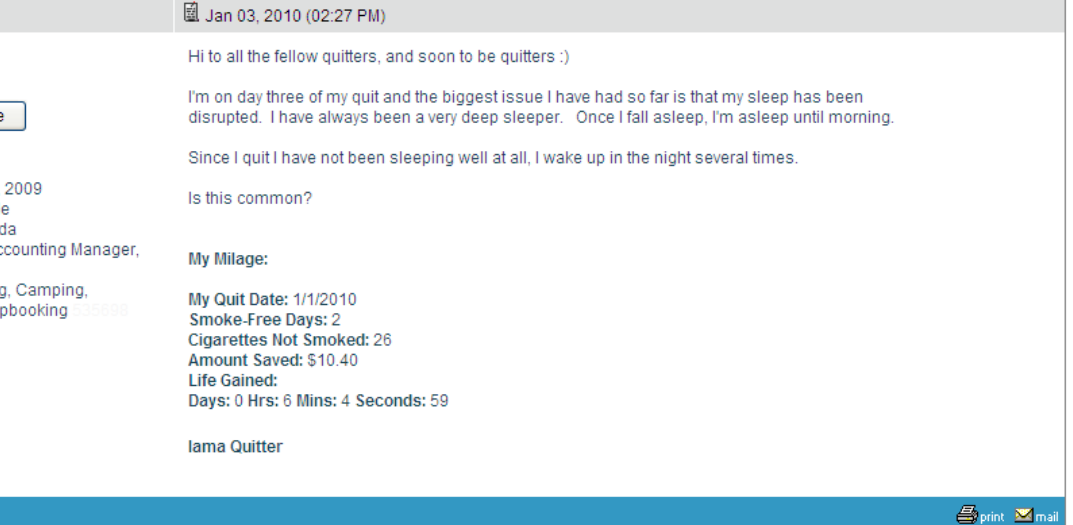
Figure 2. Screenshot of a sample StopSmokingCenter.net 6.1 support group